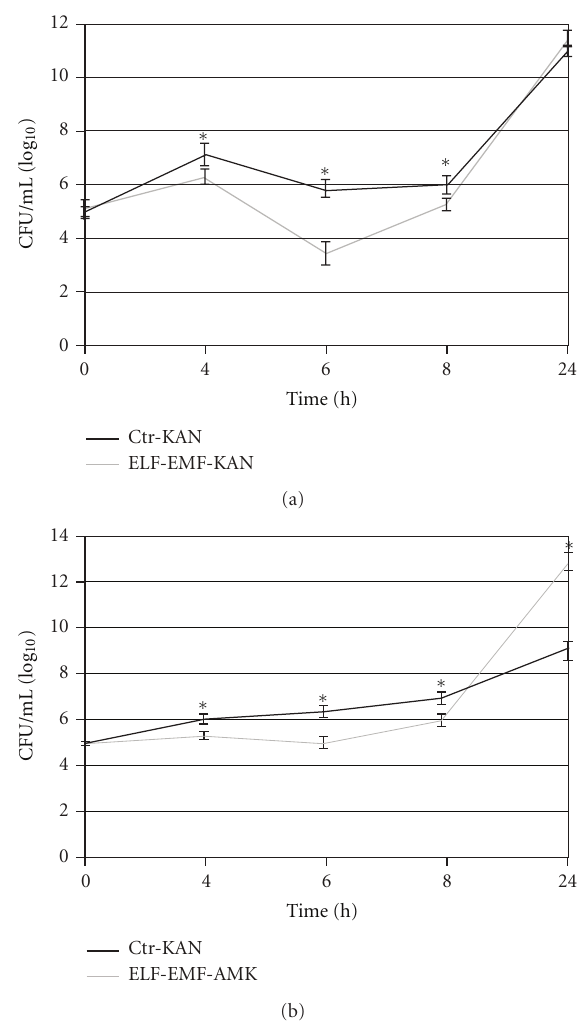
Figure 3: ELF-EMF (sinusoidal wave; 2mT; 50Hz) influenced the growth rate of E. coli (a) and P. aeruginosa (b) when incubated in the presence of subinhibitory concentration of kanamycin and amikacin, respectively. ELF-EMF-KAN: ELF-EMF exposed groups incubated in the presence of 1 µ g/mL kanamycin; Ctr-KAN: control groups incubated in the presence of 1 µ g/mL kanamycin; ELF- EMF-AMK: ELF-EMF exposed groups incubated in the presence of 0.5 µ g/mL amikacin; Ctr-AMK: control groups incubated in the presence of 0.5 µ g/mL amikacin. Data represent means ± SEM from 3 di ff erent experiments. ∗ P < 0 . 05 (one-way ANOVA followed by Tukey’s